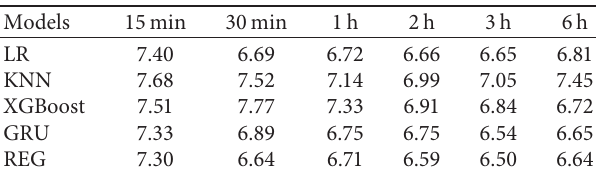
Table 2: Multimodel RMSE comparison table for different step sizes.